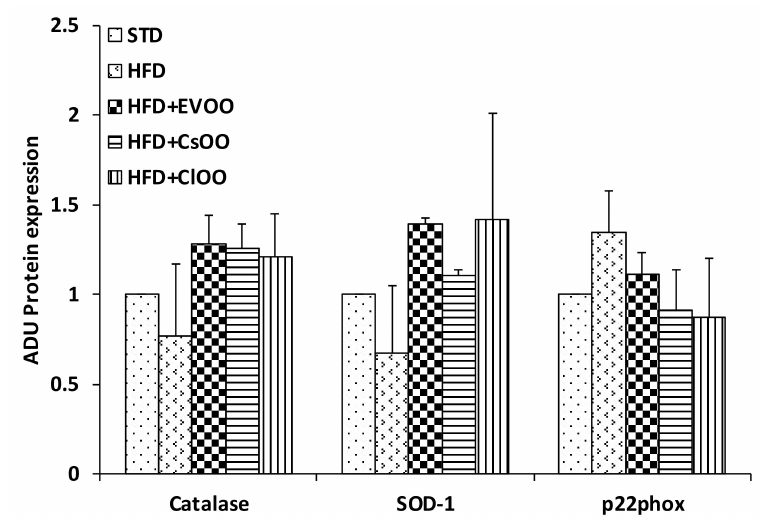
Figure 8. E ff ects of CEVOO, Ca OO and Cl OO diet supplementation on oxidant factors in aortic vessel tissues of HFD fed rats. Quantification of western blots for Catalase, SOD-1 and p33phox reported in Figure 7, panel A. Data are reported as a ratio of arbitrary density unit (ADU) target protein / β -actin and are means ± standard deviation ( n = 3). Data are reported as fold change vs. STD which was assigned to 1.